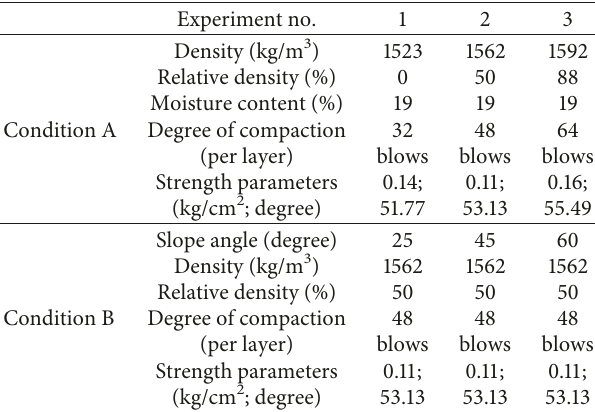
Table 1: Experiments